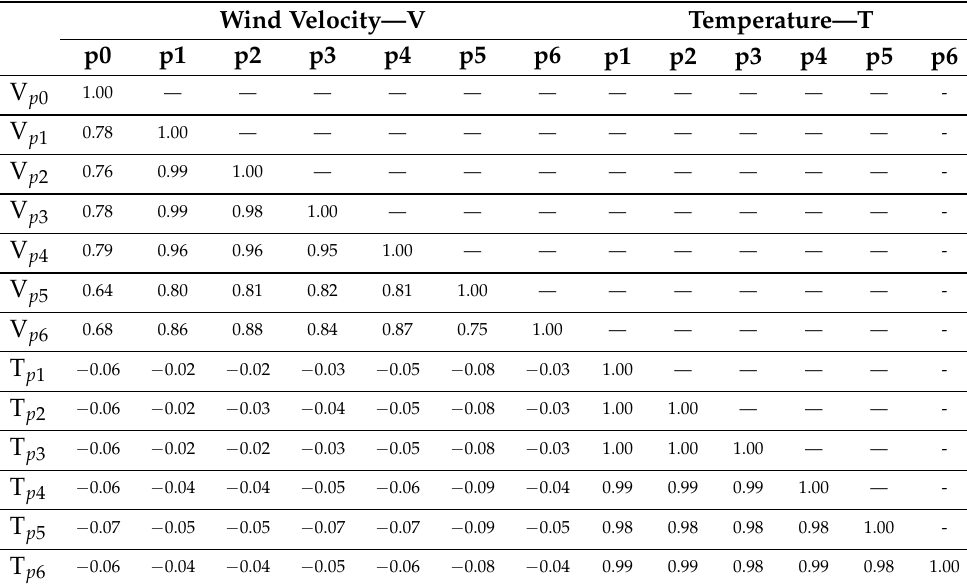
Table 9. Mutual correlations matrix, input